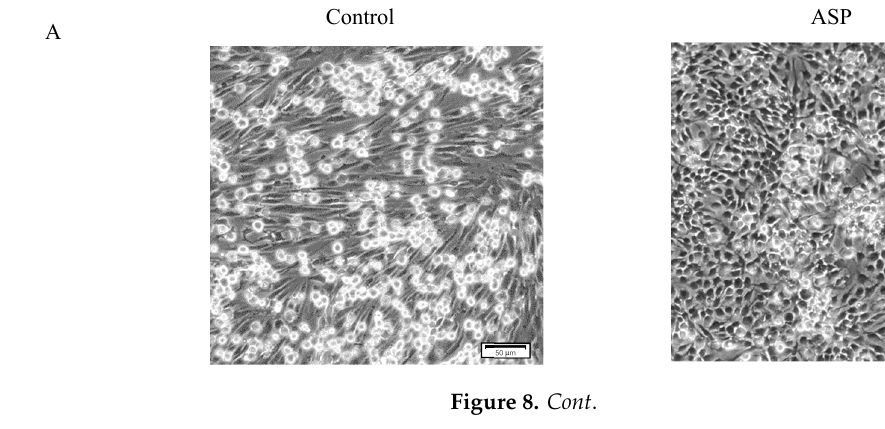
Figure 8. Aspartate inhibits the yield of ISKNV in CPB cells. ( A ) CPE of ISKNV-infected CPB cells (scale bar = 50 µm); ( B ) the viral copy number was validated via fluorescent real-time PCR (TaqMan).